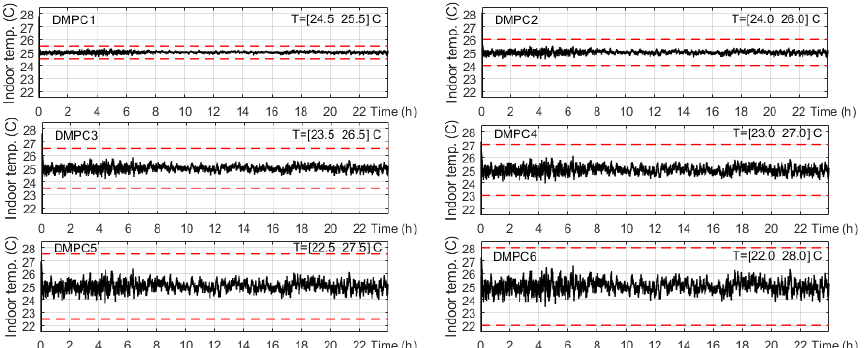
Figure 11. Indoor temperature deviation of the DMPCs for IAC control of case 1 (the blue line is the indoor temperature, and the red dash lines are the minimum and maximum limits of the indoor temperature).